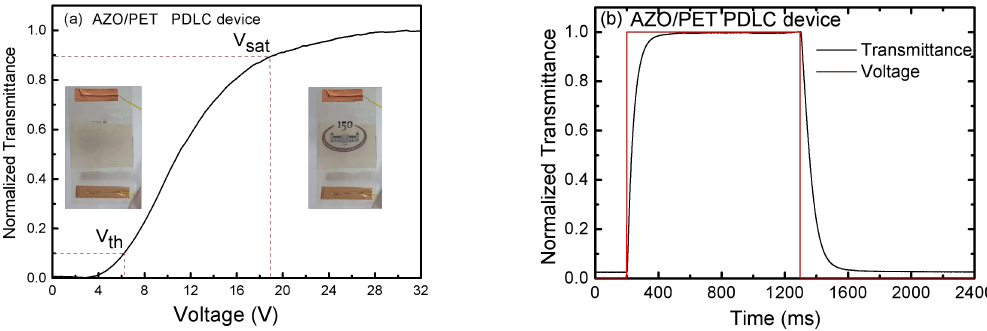
Figure 7. (a) Voltage-transmittancebehavior ofAZO/PET PDLC deviceand(b)